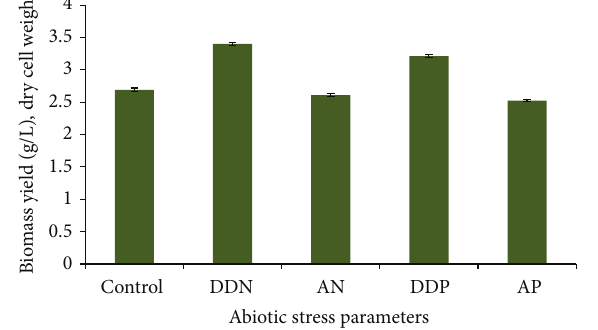
Figure 3: Bar graphs showing biomass yield (g/L) of R . africanum in log phase (14 days) under different nutrient limited conditions (DDN, AN, DDP, and AP). 𝑃 = probability value (significant level); 𝑃 ≤ 0.05